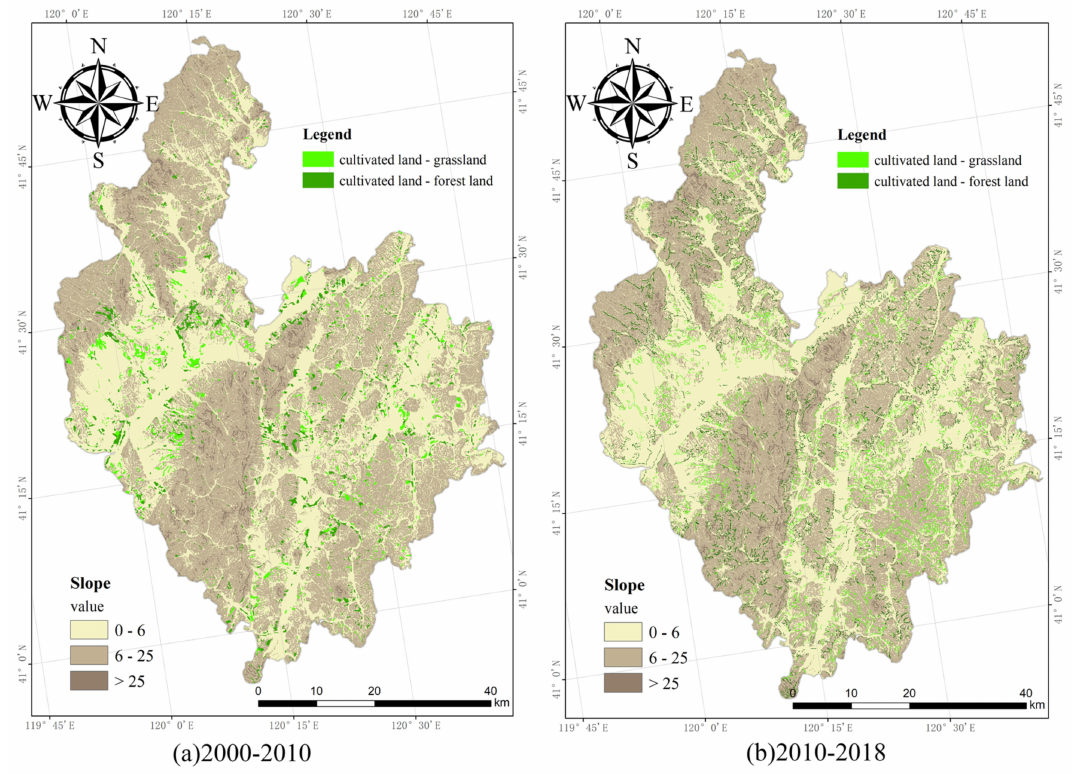
Figure 8. Implementation of the “Grain for Green” project in study area ( a ) 2000–2010 ( b )